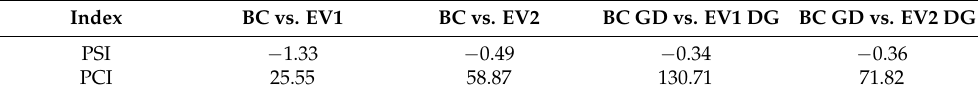
Table 7. PSI and PCI indices.